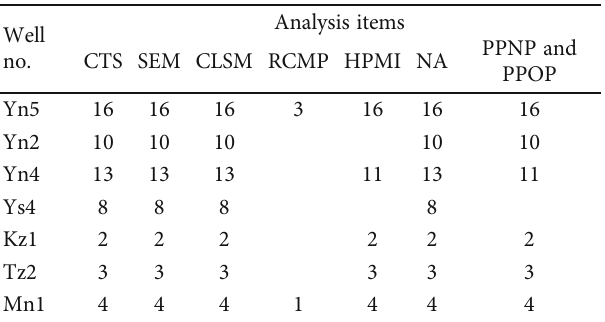
Figure 2: Structural section map of east Kuqa Depression. Table 1: Analysis items and number of sandstone samples in the study